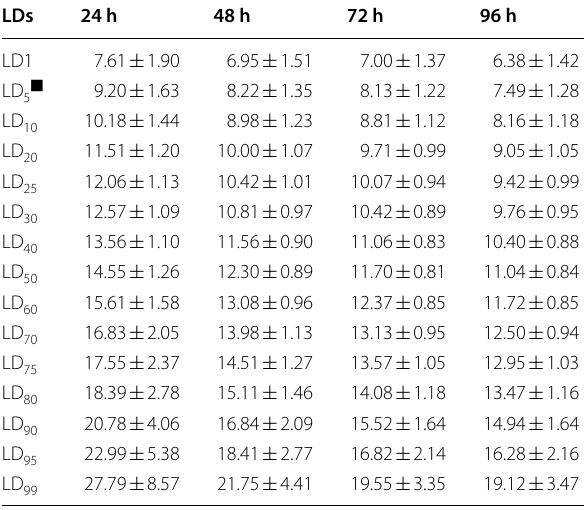
Table 3 The lethality percentile doses (LDs, mg/kg b. wt.) of AFB at 24, 48, 72, and 96 1